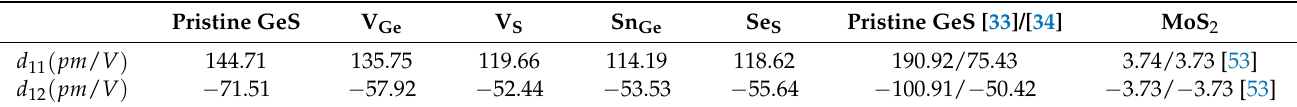
Table 4. Piezoelectric strain coefficients d ij for pristine GeS, GeS with vacancies (V Ge , V S ), and GeS with substitutional atoms (Sn Ge , Se S ) compared with previous studies for pristine GeS and MoS 2